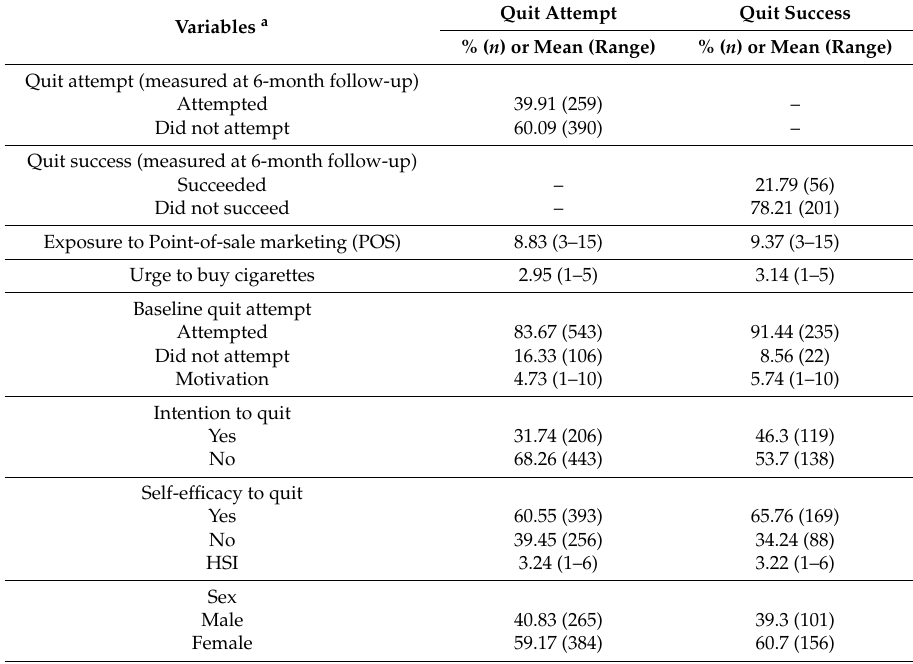
Table 1. Sample characteristics for the quit attempt ( n = 649) and quit success ( n = 257) analysis. Variables